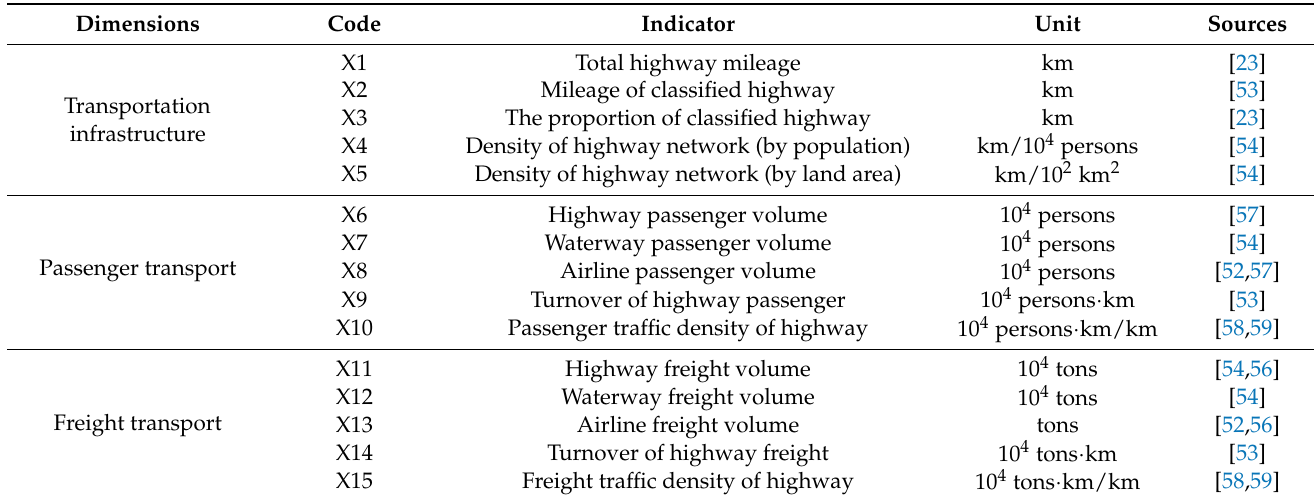
Table 1. Indicators for the field strength